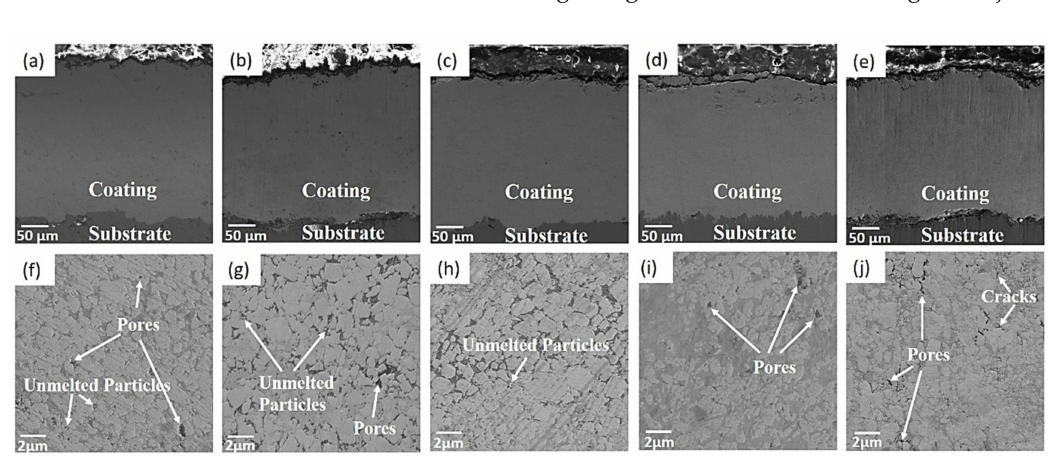
Figure 3. Cross-sectional images at low and high magnification of ( a , f ) as-sprayed; ( b , g ) HT 650;